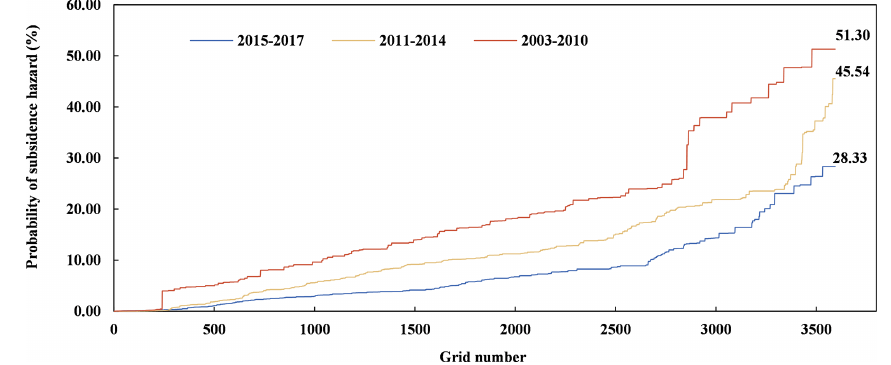
Figure 9. Probability distribution of subsidence hazard for the three time periods from 2003 to